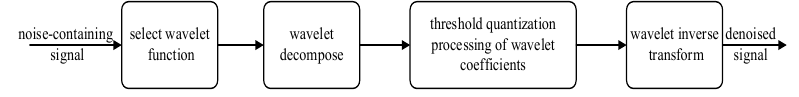
Fig. 1. Flow chart of wavelet threshold denoising